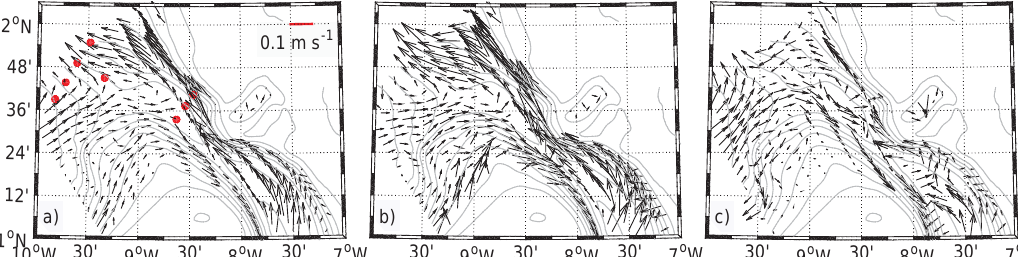
Figure 7. Modelled (a) annual mean currents and monthly mean currents in (b) August 2008 and (c) March 2009 at 300m depth. Isobaths are shown every 100m (grey, thin lines) and every 500m (thick, grey line), and the circles indicate the mooring locations.